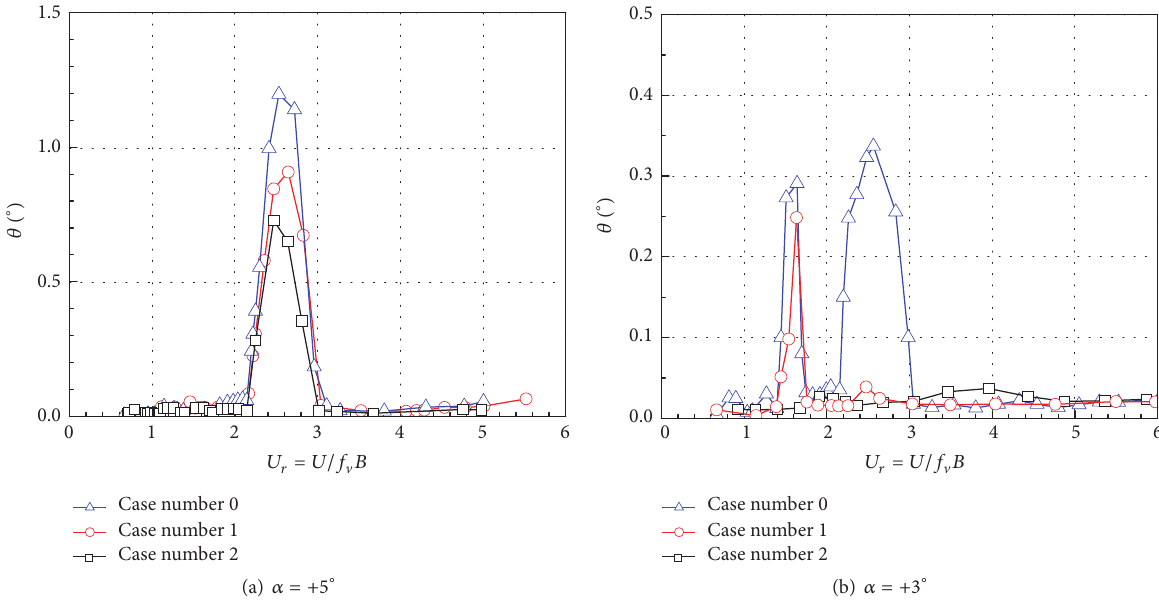
Figure 15: Comparisons of the RMS torsional displacement 𝜃 among Cases #0 , 1 , and 2 .